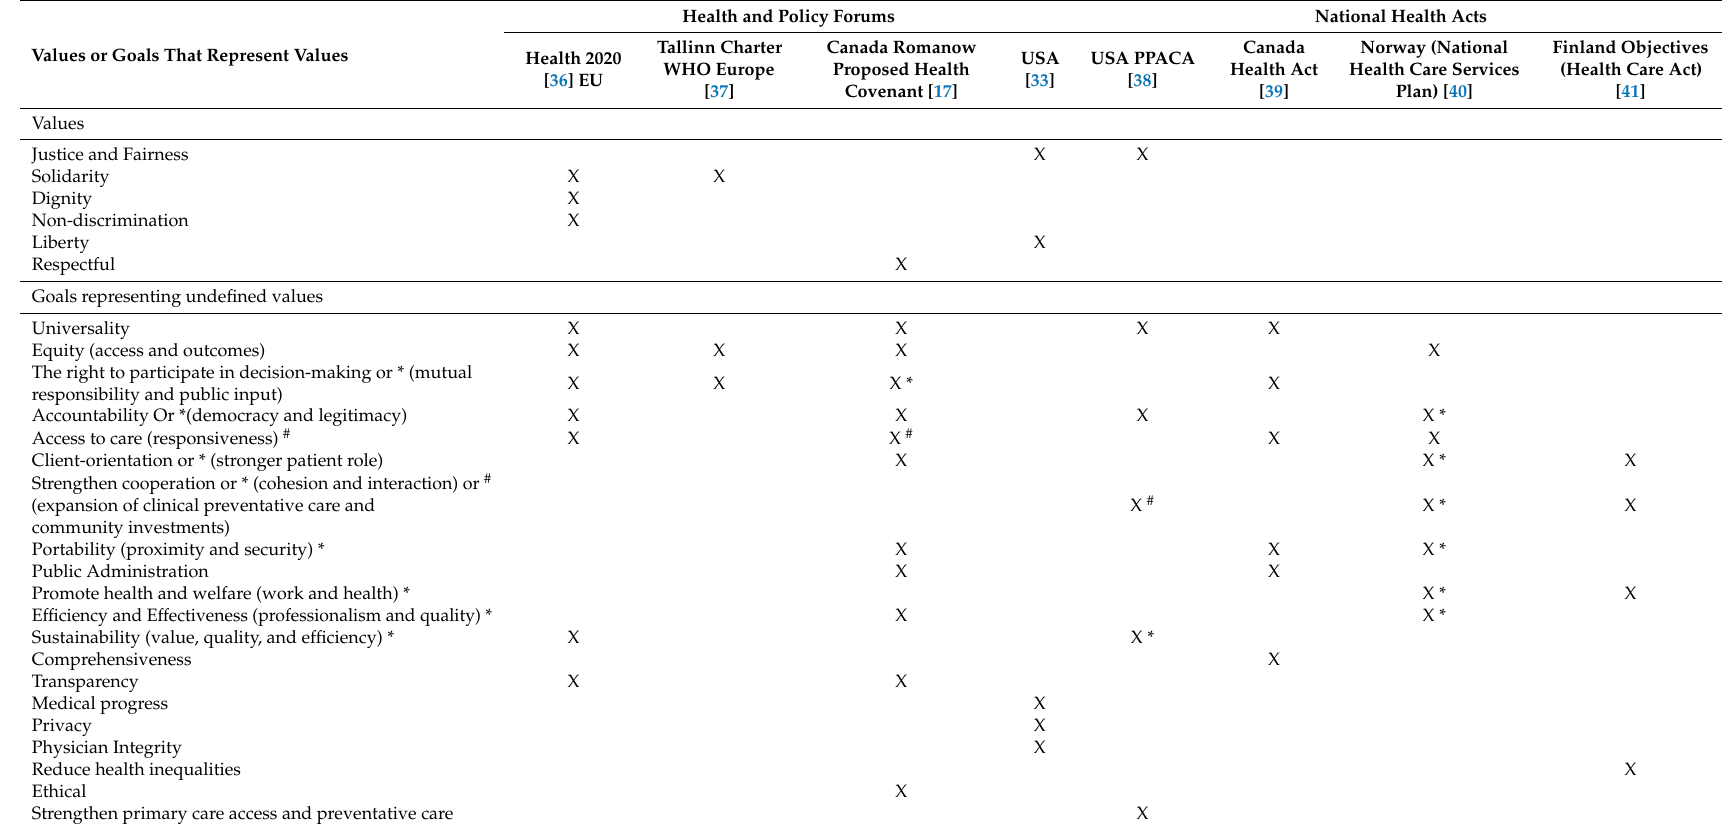
Table 1. Values described for health care in forums and